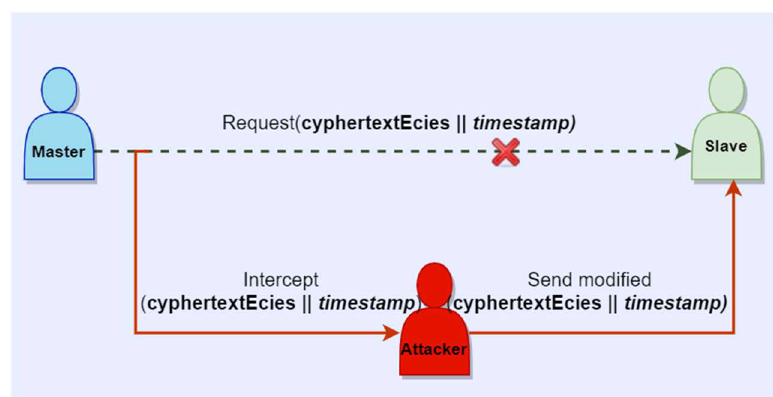
Figure 6. Replay attack for encrypted master-slave communication.